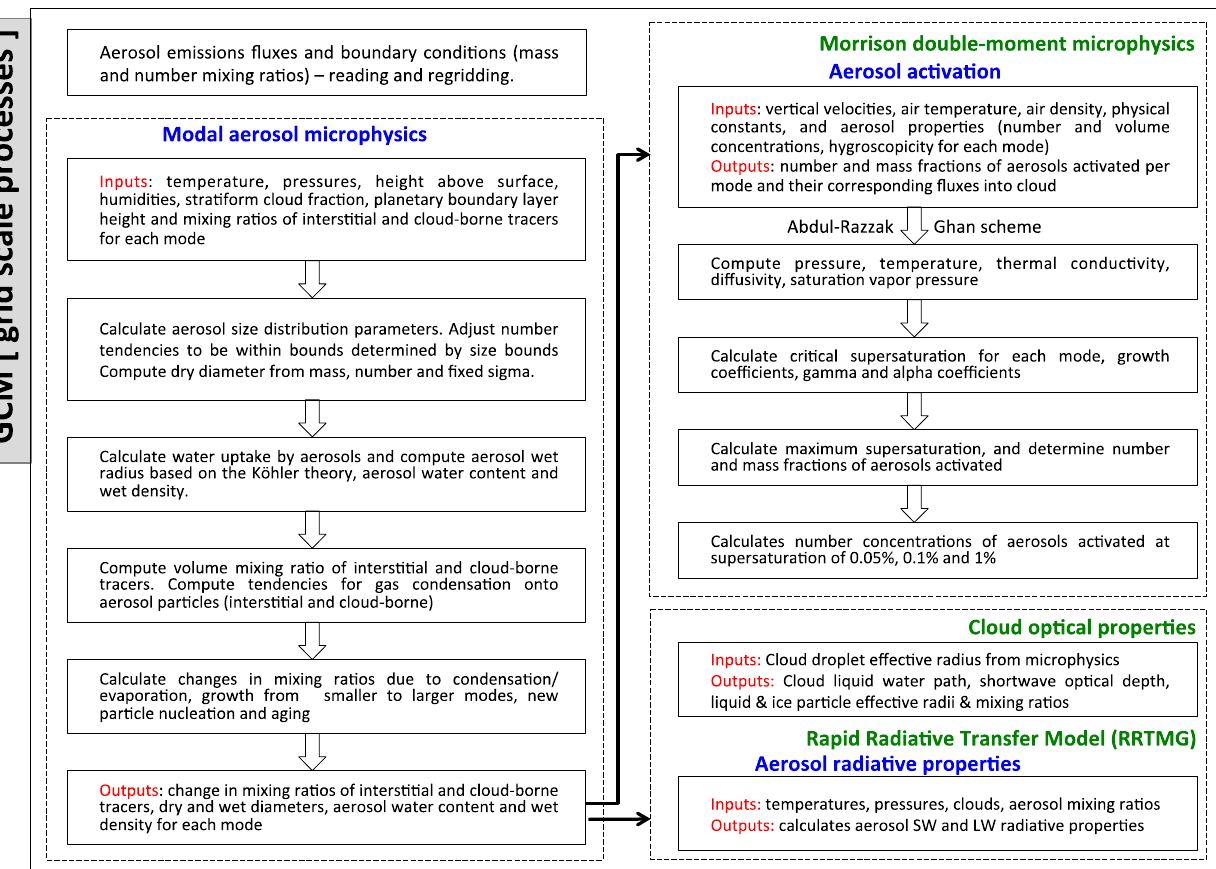
Figure 1. Flowchart of the AMIC module incorporated into the physical parameterization of BAM. Outputs from AMIC are fed to cloud microphysics, cloud optical properties, and radiation routines to compute aerosol activation, changes in cloud optical properties, and aerosol radiative properties, respectively.